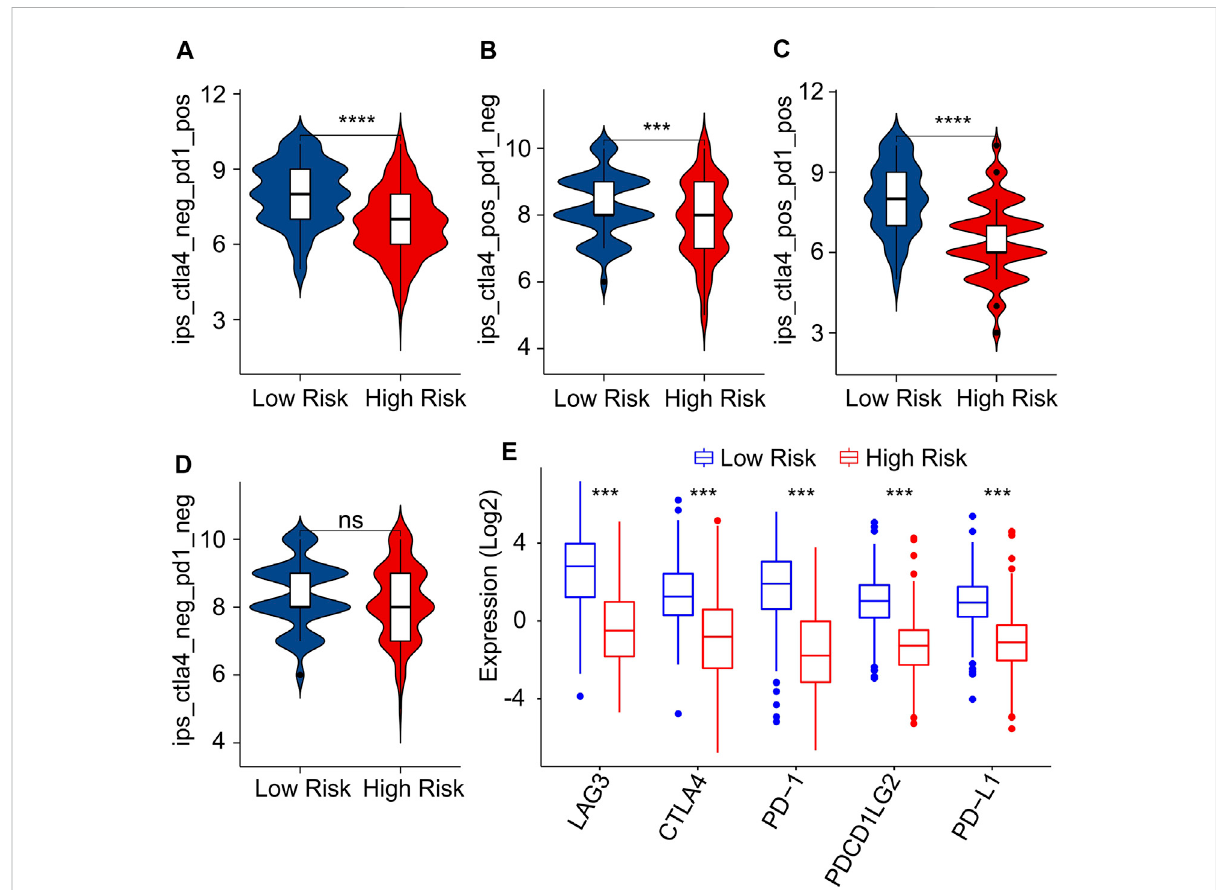
FIGURE 9 Immunophenoscore (IPS) and immunecheckpointinhibitor (ICI) expressionof CM patients in low- and high-risk group. (A – D) IPS score shows theresponsetoPD-1andCTLA-4forCMpatientsinlow-andhigh-riskgroups. (E) Immunecheckpointsinhibitor(ICI)expressionofpatientswithCM in low- and high-risk